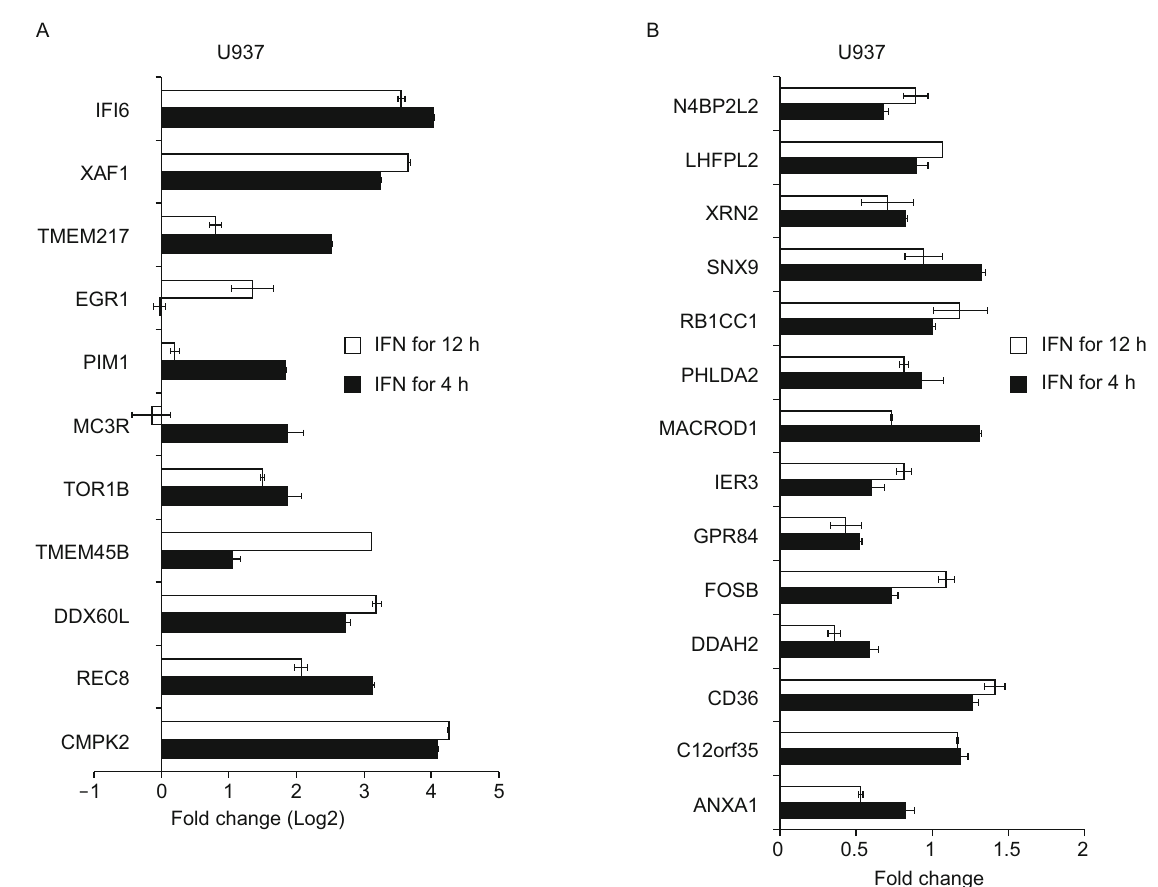
Figure 3. Validation of new ISG candidates in U937 cells by qRT-PCR. U937 cells were treated with Con-IFN for 0 h, 4 h or 12 h. The mRNA levels of new ISG candidates were analyzed by qRT-PCR, as described in the legend to Fig. 2. Data represented are mean ± SD of two